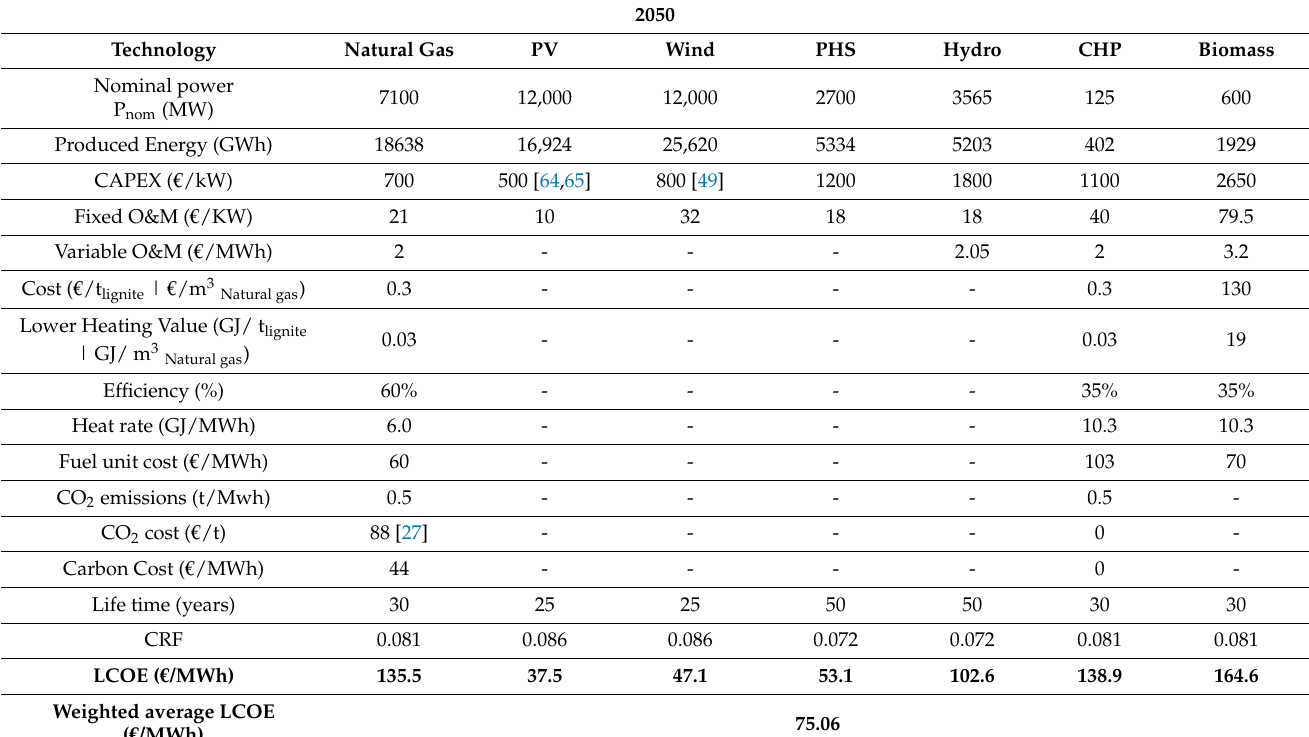
Table 6. Data used for LCOE calculation for